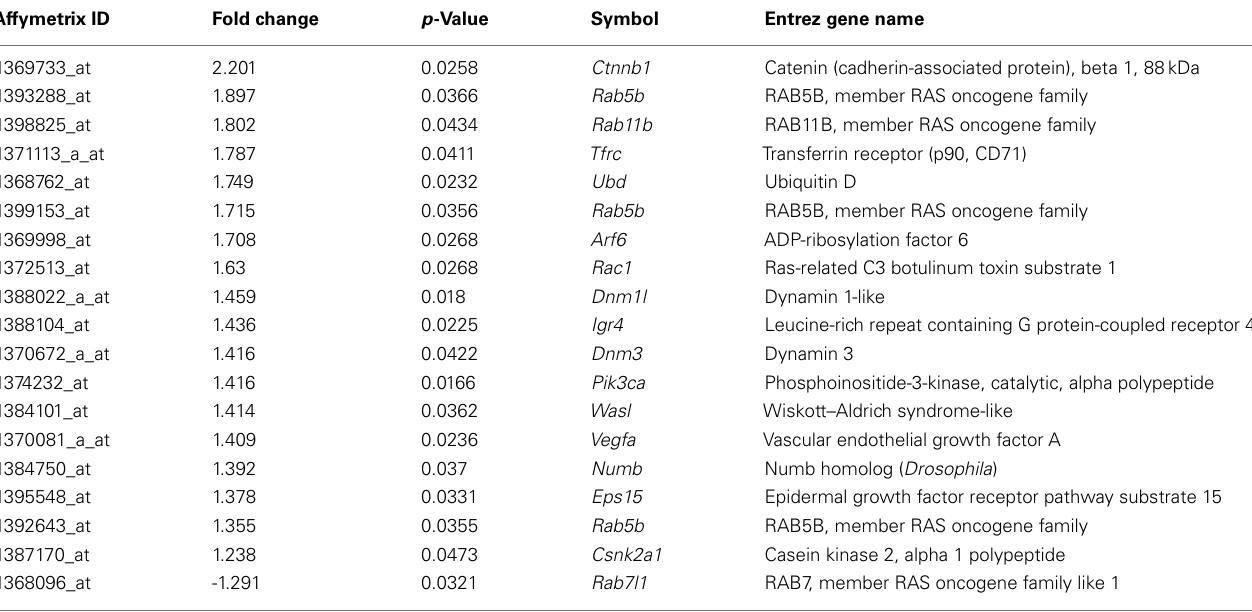
Table 1 | Differentially expressed transcripts in the clathrin-mediated endocytosis